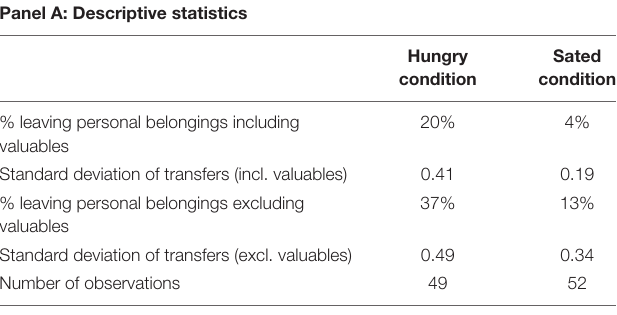
TABLE 5 | Hidden experiment for trusting behavior. Panel A: Descriptive